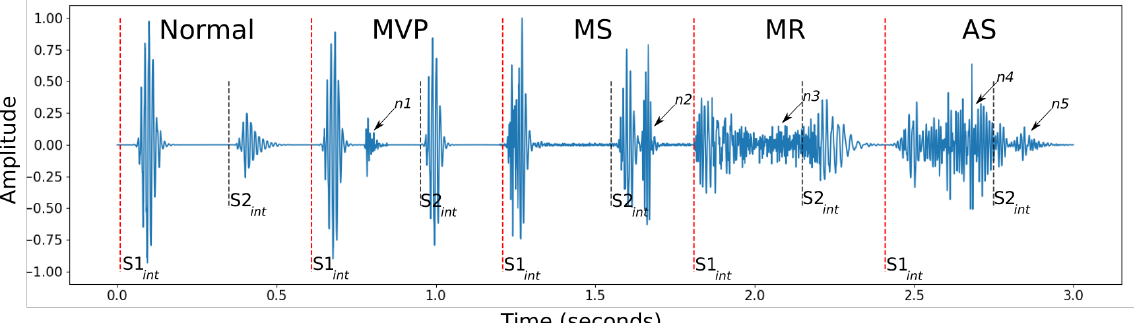
Figure 1. Heart sounds (S1, S2) and noises ( nX ) present in different phonocardiographic recordings, concatenated for graphical purposes. The complete cardiac cycle has an approximate period of 800 ms, where the average duration of normal heart sounds is 70–150 ms for S1 and 60–120 ms for